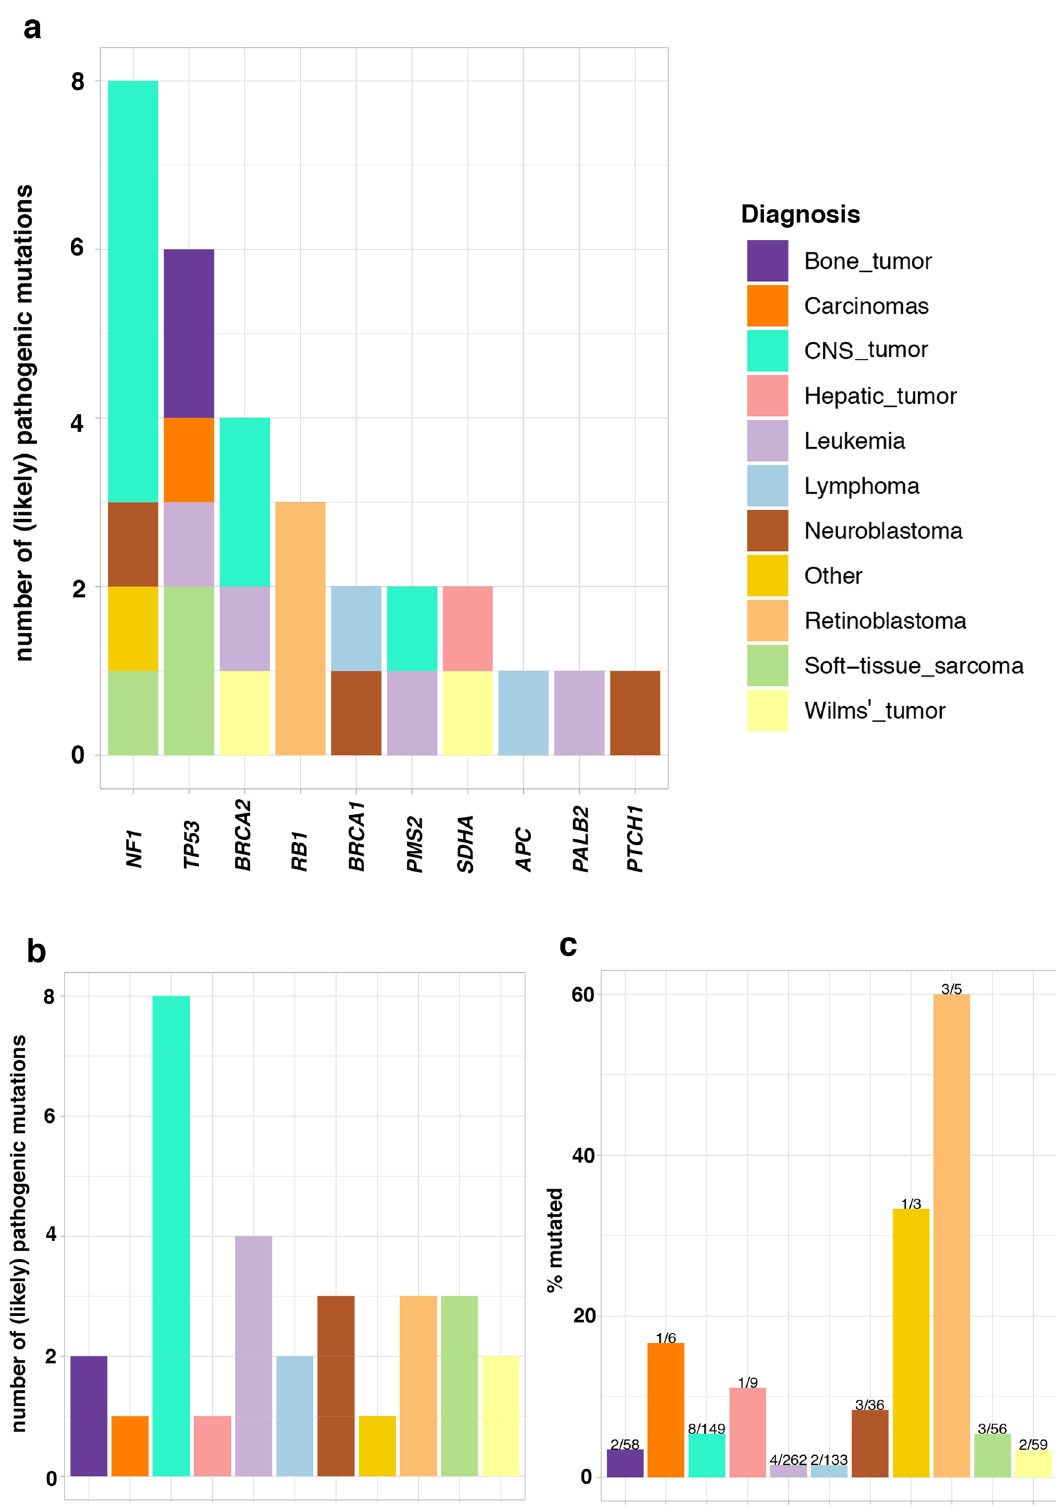
Figure 2. Distribution of germline pathogenic and likely pathogenic variants in patients with different pediatric diagnoses in the LCCG cohort. ( a ) Number of patients with (likely) pathogenic variants per gene. Colors indicate the diagnosis group of each patient in which the variant was detected. ( b ) Total number of patients carrying (likely) pathogenic variants per cancer diagnosis group for all genes summed. ( c ) Percentage of patients with (likely) pathogenic variant per cancer diagnosis group for all genes summed. The number of patients carrying (likely) pathogenic variants and the total number of patients in each diagnosis group is shown above the